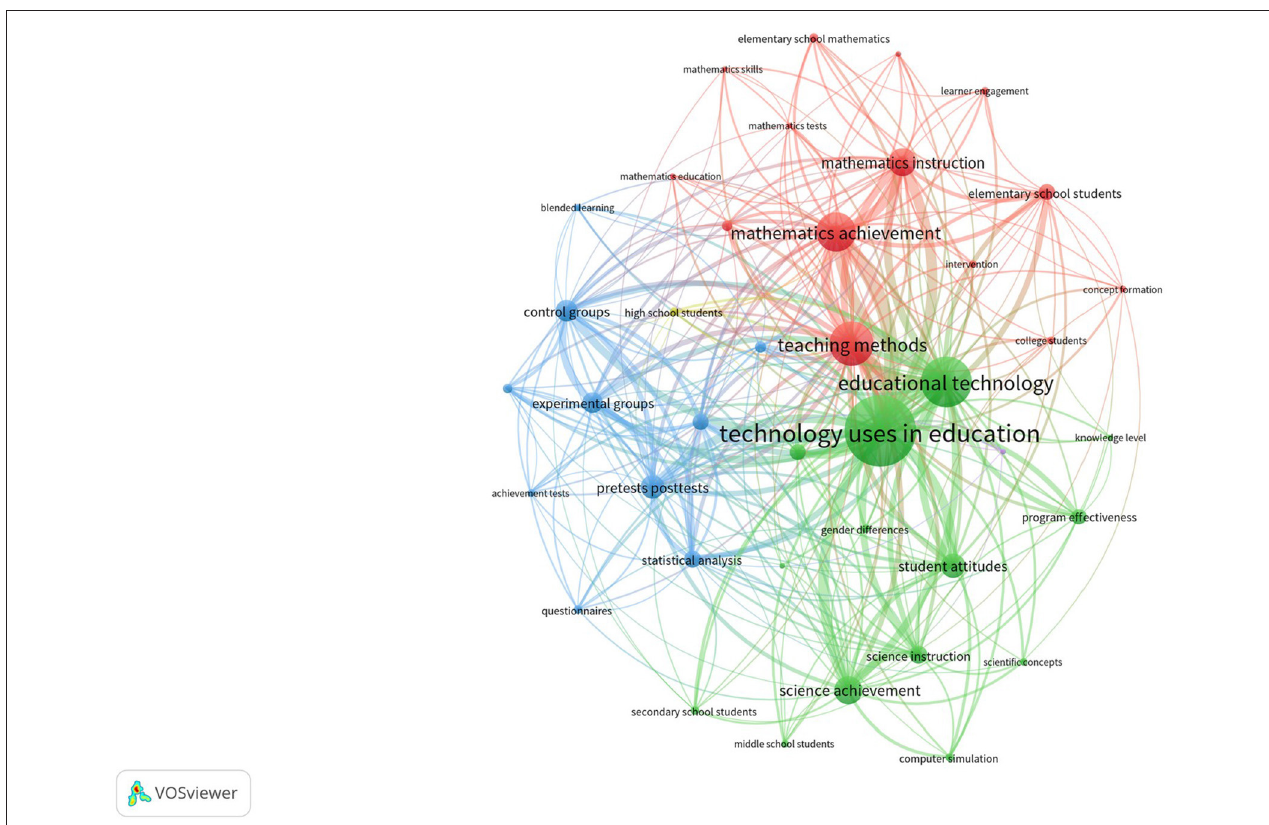
FIGURE 2 | Map of co-occurrence by keywords of the articles reviewed. Source: prepared with VosViewer.